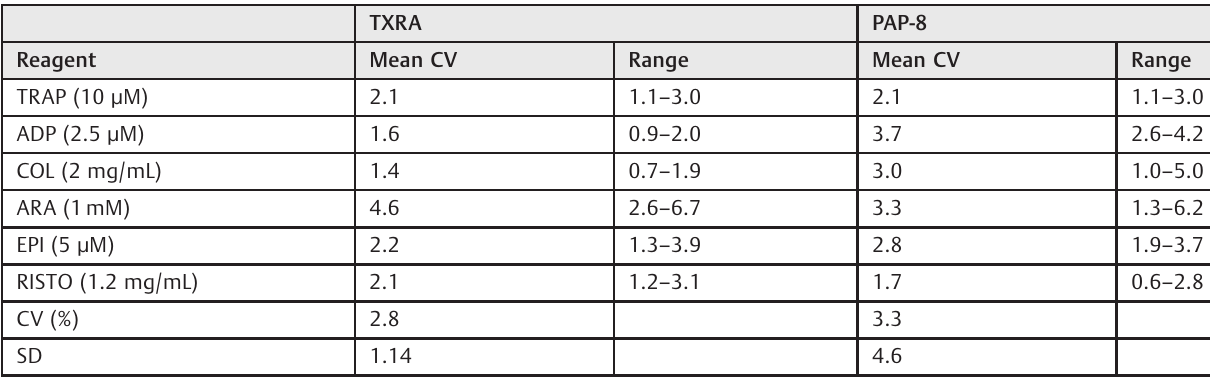
Table 1 Precision data of